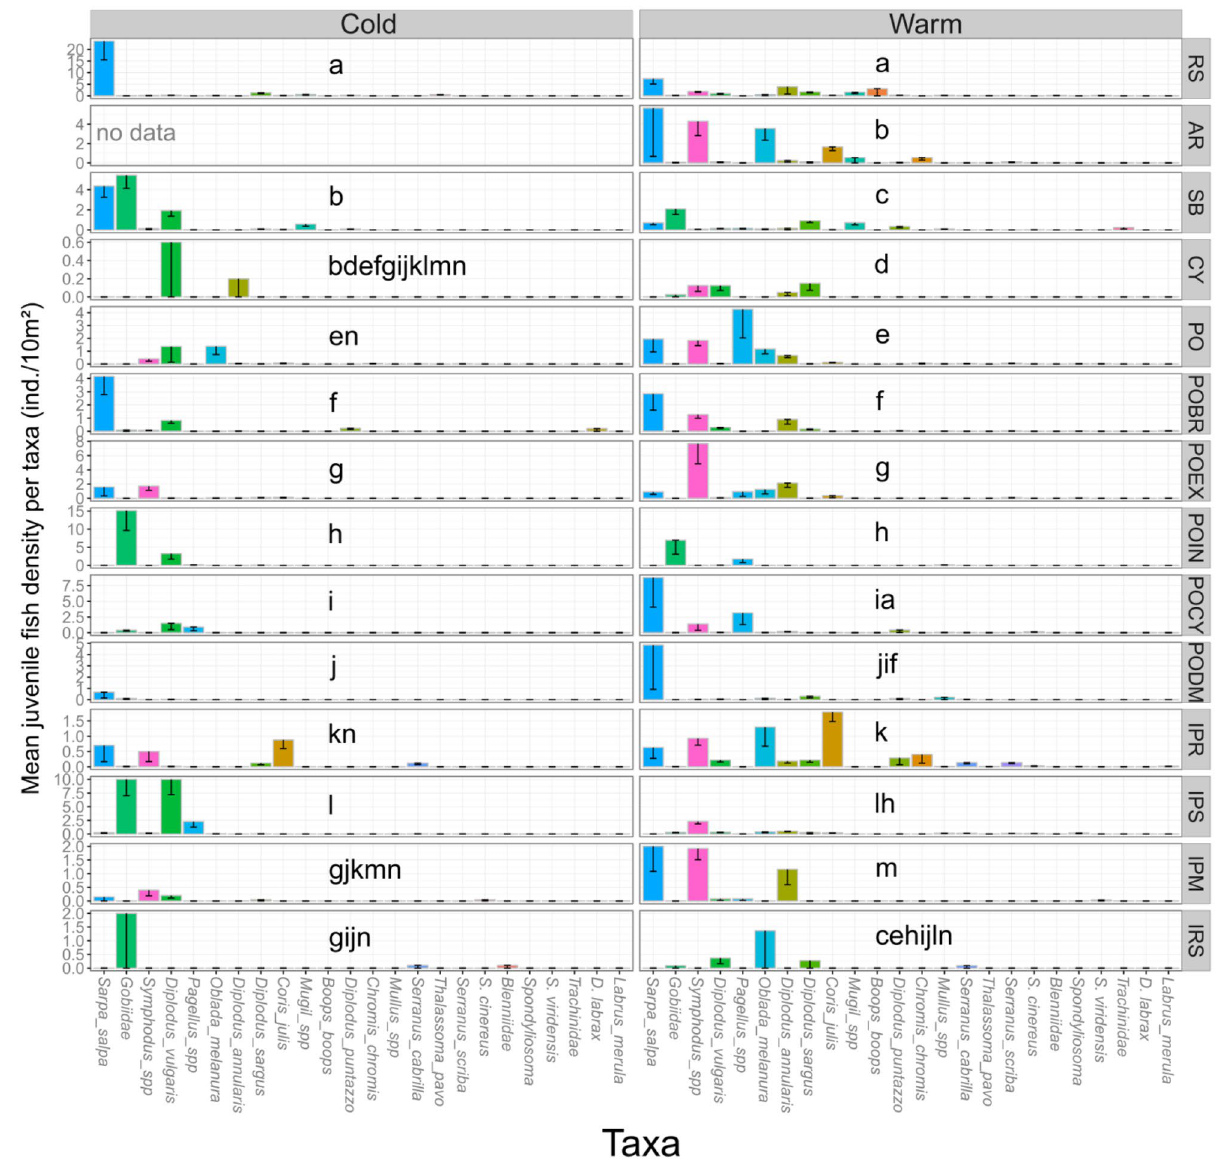
Figure 6. Mean (± SE) juvenile density of each taxa in juvenile habitats for both periods (Cold and Warm). Atherinidae and larvae, as well as the 15 least abundant taxa, were removed for a clearer representation. Note that vertical axes display different scales. S. cinereus = Symphodus cinereus ; S. viridensis = Sphyraena viridensis ; D. labrax = Dicentrarchus labrax ; Details of taxa are given in Table S2. For each period, comparisons of juvenile fish assemblages between juvenile habitats (pairwise tests results) are given (treatments that share at least one lower case character do not significantly differ).